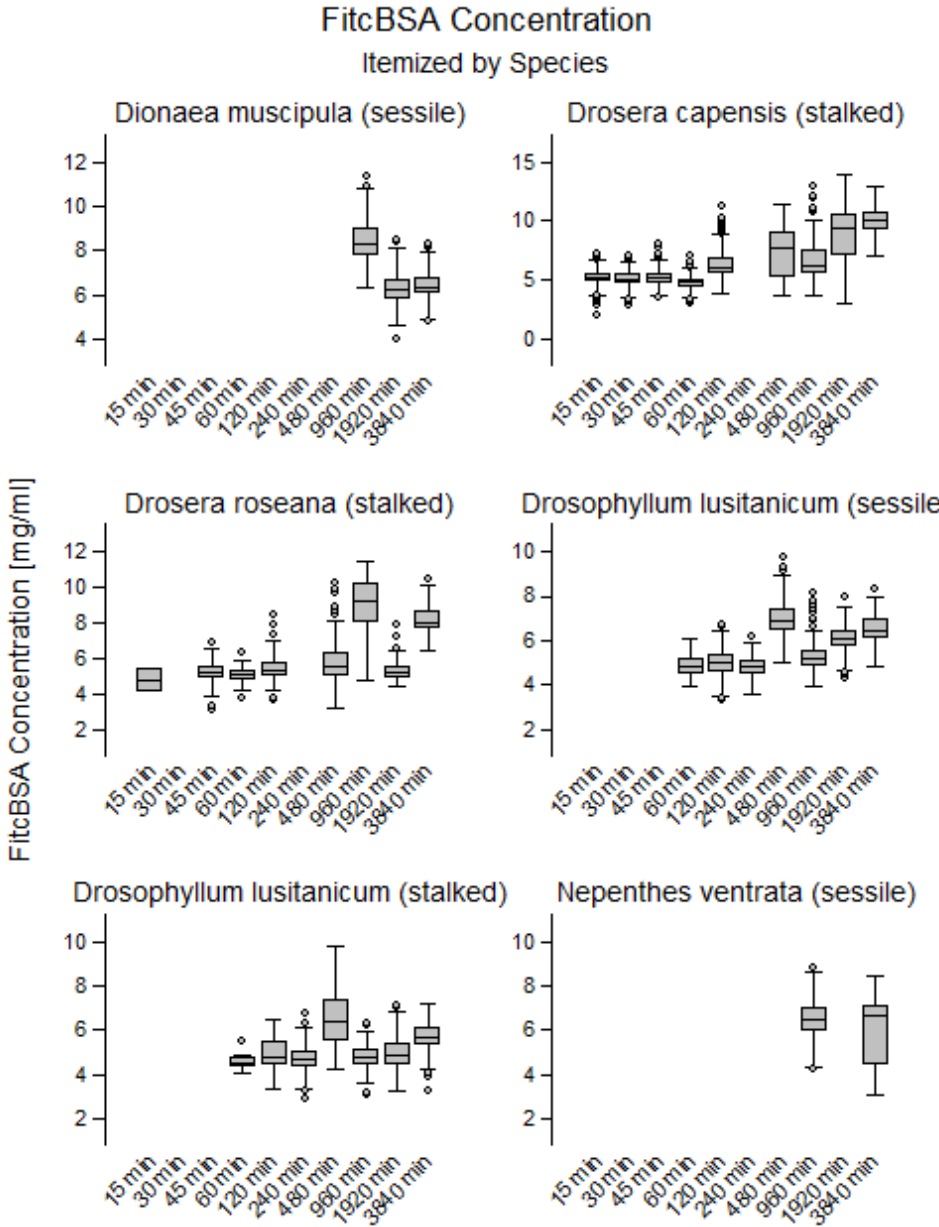
Figure 3. Temporal changes of FITC-BSA concentrations in observed glands in Dionaea muscipula , Drosera roseana , Drosera capensis , Nepenthes × ventrata and stalked and sessile glands in Drosophyllum lusitanicum . Estimated FITC-BSA concentrations within vesicles exhibited a trend toward increase in all species with the exception of N. × ventrata and D. muscipula . The concentrations in N. × ventrata stayed constant, whereas in D. muscipula concentration decreased significantly over time.